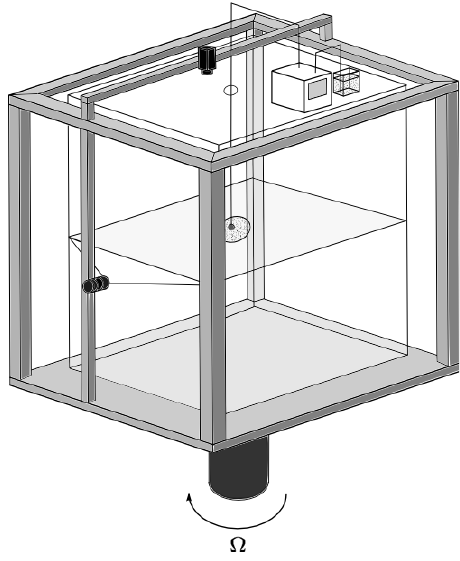
Figure 1. Schematic representation of the experiment tank of dimensions 50 × 50 × 70 cm 3 . This setup has Coriolis parameters ranging from 1 to 7 rad / s, and buoyancy frequencies ¯ N from 0 . 6 to 2 . 4 rad / s. While the tank is rotating and once the linearly stratified fluid inside has reached solid-body rotation, fluid at mid-density and seeded with PIV particle and dye is injected by a pump in the middle of the stratification on the axis of rotation. As the fluid is injected on the axis of rotation of the tank, its rotation rate in the rotating frame of reference is initially Ω = (cid:31) Ω , imposing an initial Rossby number v Ro (0) = Ω v (0) / 2 Ω = (cid:31) 1 /